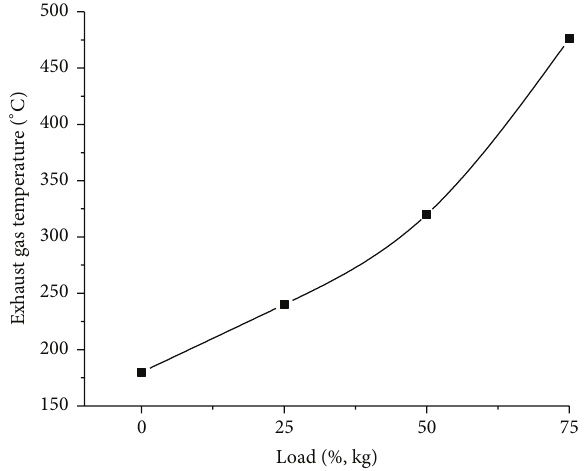
Figure 4: Variation of exhaust gas temperature versus percentage of